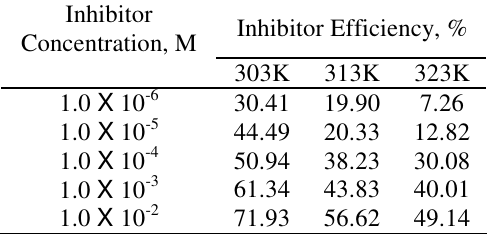
Table 4. The inhibition efficiency (%) for mild steel corrosion in 2 M HCl solution by pyridoxolhydrochloride at different temperatures.